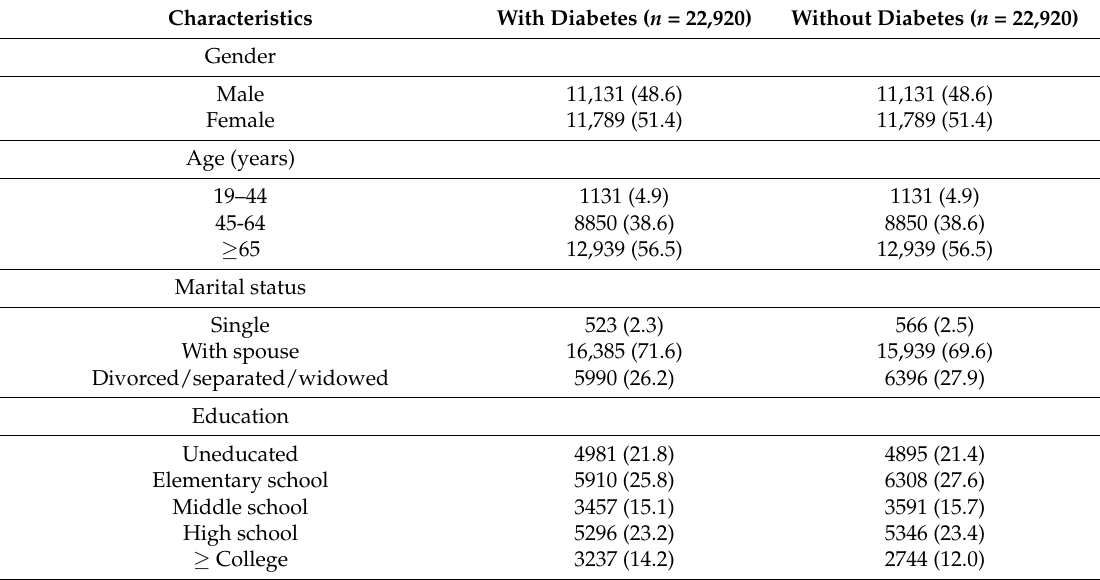
Table 1. General characteristics of participants with and without